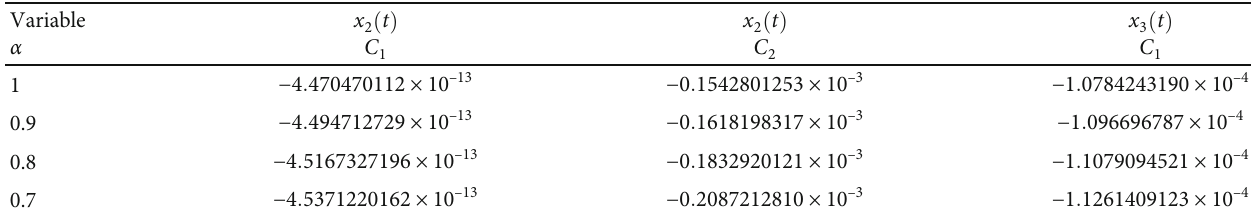
Table 5: Control-convergence parameters C